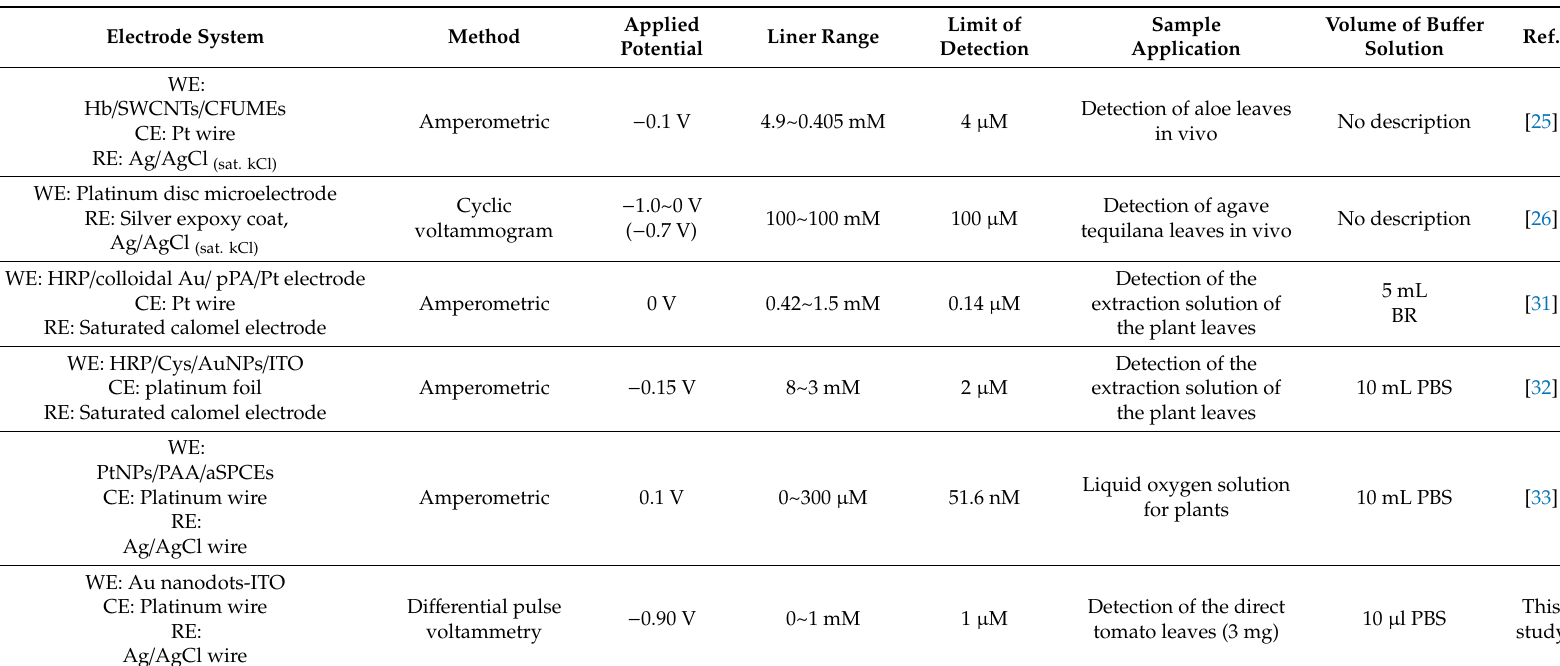
Table 1. List of the analytical performances of the electrochemical methods for the detection of H 2 O 2 in